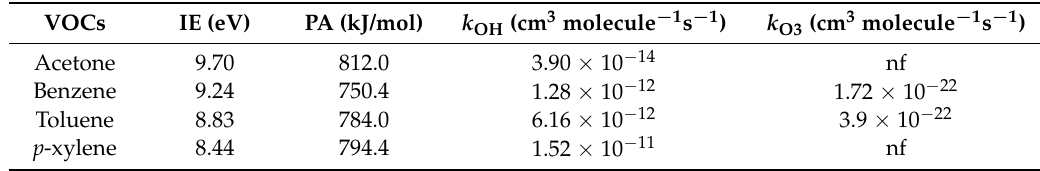
Table 1. The values for ionization energies, proton affinities, and reaction constants for reactions with the • OH and O 3 of VOCs.